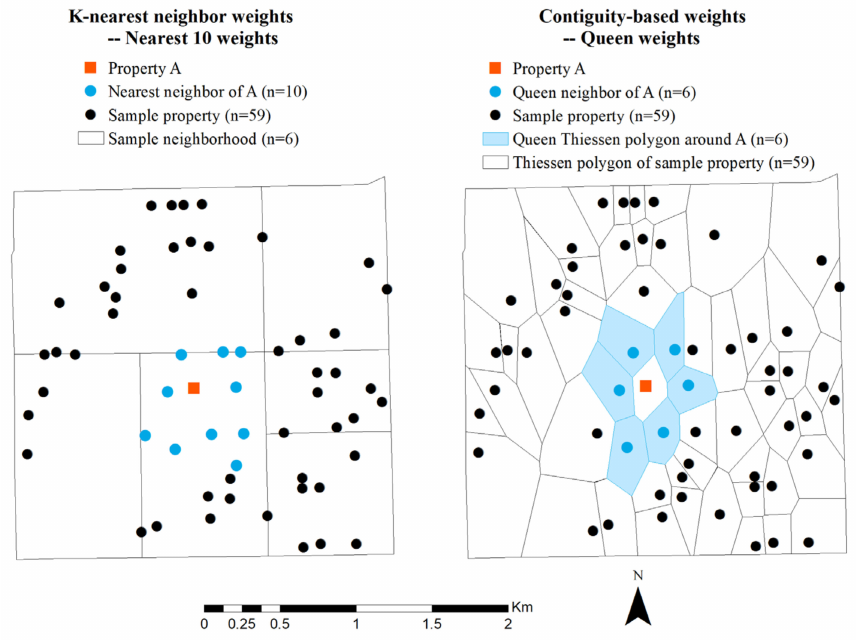
Figure 2. An illustration of the k-nearest and the queen neighbor